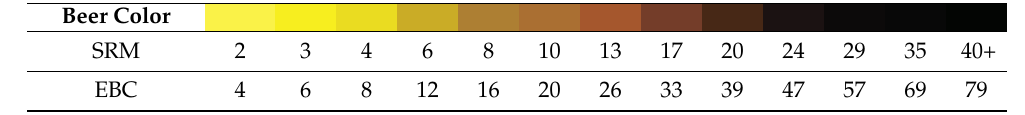
Table 3. Beer color with